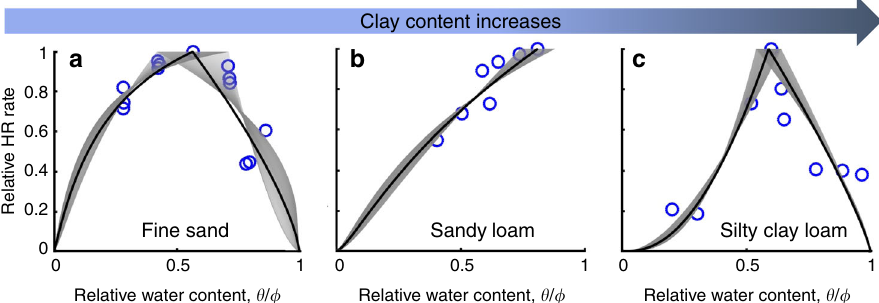
Fig. 5 Calibration of moisture function, f m , using incubation data. Blue circles are experimental data for different soil types: a fi ne sand 18 , b sandy loam 25 , and c silty clay loam 50 . Gray ranges represent the fi tted f m with respect to different optimum water contents, θ op , whose values were allowed to vary in a range. The black lines represent the best- fi t f m using the averaged values of a , b , and θ op corresponding to the gray ranges (see Supplementary Data 1)